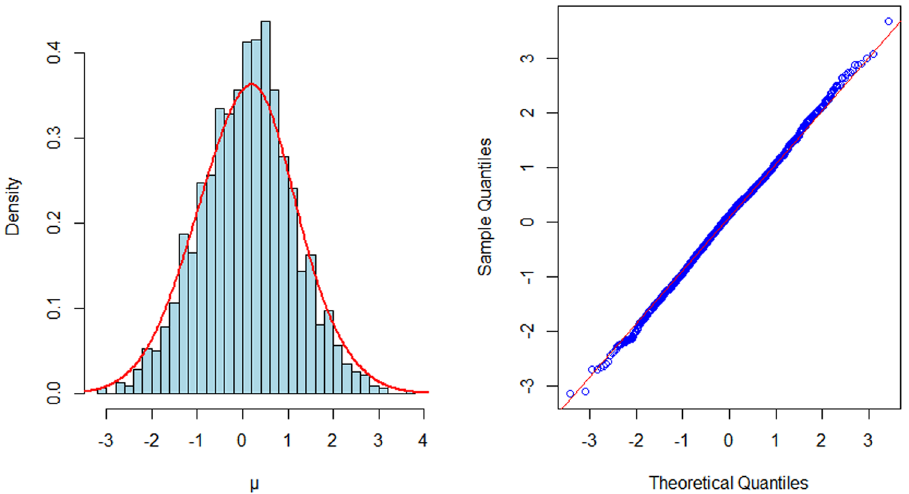
Figure 5: Histogram and normal Q – Q plot of